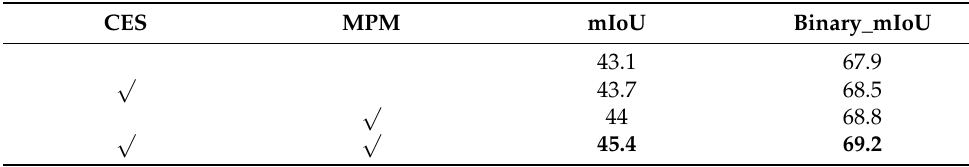
Table 6. Ablation experiments on different components.